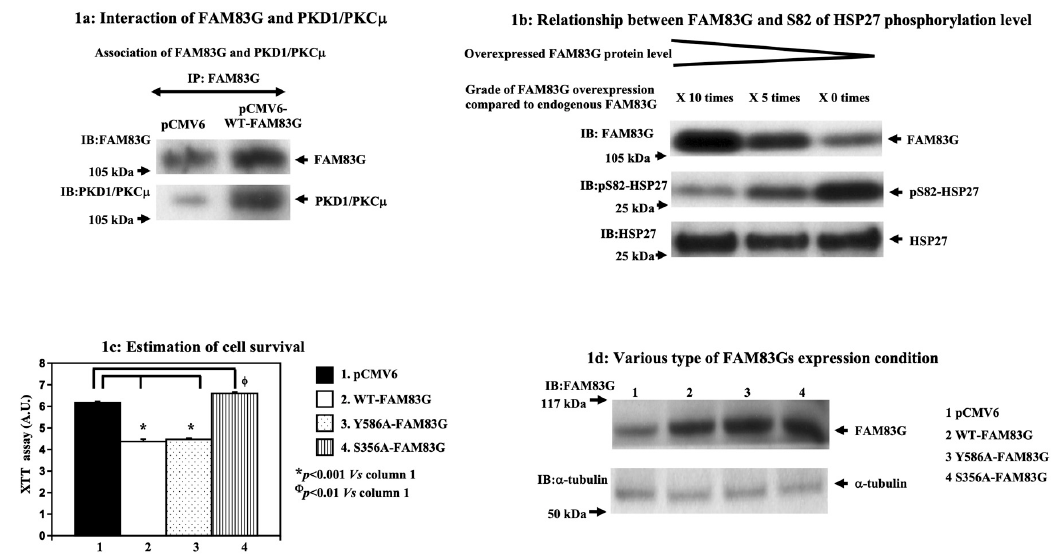
Figure 1. E ff ect of overexpressed FAM83G with or without S356 phosphorylation on cell numbers. ( a ) Interaction between FAM83G and PKD1 / PKC µ ; pCMV6 and pCMV6-wild type (WT)-FAM83G were expressed in CHO cells, FAM83G was immunoprecipitated, and then the immunoprecipitated FAM83G was immunoblotted with an antibody specific for FAM83G and PKD1 / PKC µ . Endogenous FAM83G was co-immunoprecipitated with endogenous PKD1 / PKC µ (pCMV6 lane, control sample). Overexpressed FAM83G was co-immunoprecipitated with increased PKD1 / PKC µ levels (pCMV6-WT-FAM83G lane). The experiments were independently performed in triplicate. ( b ) Phosphorylation of the HSP27 S82 residue is inversely correlated with the levels of FAM83G expression. Upper panel: exogenously expressed FAM83G and endogenous FAM83G protein levels in CHO cells following immunoblotting (IB) with a FAM83G-specific antibody. Middle panel: the relative levels of S82-phosphorylated HSP27 are shown by IB with a specific anti-phospho-(S82) HSP27 antibody. Lower panel: relative HSP27 protein levels following IB with a specific anti-phospho-(S82) HSP27 antibody (strip and re-probe technique). The experiments were independently performed in triplicate. ( c ) Cell survival following the expression of pCMV6, WT-FAM83G, Y586A-FAM83G, and S356A-FAM83G in CHO cells; cell survival (relative number of live cells), as measured by the XTT assay. An empty pCMV6 plasmid transfected into the CHO cells acted as the control. The results of the statistical analyses, which are shown to the right of the bar graph, indicated that phosphorylation at S356 was required for WT-FAM83G overexpression to significantly reduce live cell numbers. The experiments were independently performed in triplicate. ( d ) Expression levels of WT-FAM83G and the FAM83G mutants; exogenously expressed FAM83G protein levels were approximately 7-fold greater than the endogenous FAM83G level. The relative levels of endogenous-tubulin are shown as loading controls. The experiments were independently performed in triplicate.